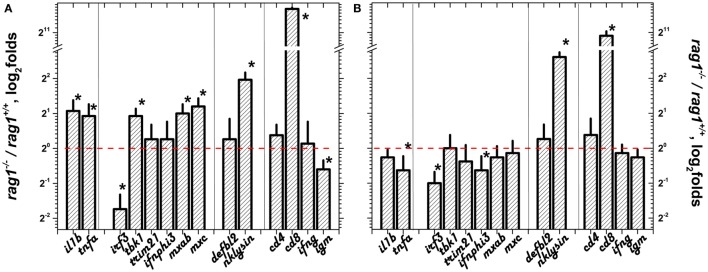
Differential expression in skin/fins of adult zebra fish before and after spring viremia carp virus (SVCV) infection. The transcript differential expression folds of rag1−/−/rag1+/+ adult zebra fish in skin/fins were calculated as in Figure 1: (A) before infection and (B) 3 days after SVCV infection. Means and SDs were represented (n = 4–6 zebra fish). Red dashed line, onefold boundary. *Statistically different from onefold with p < 0.05 by the t-test.